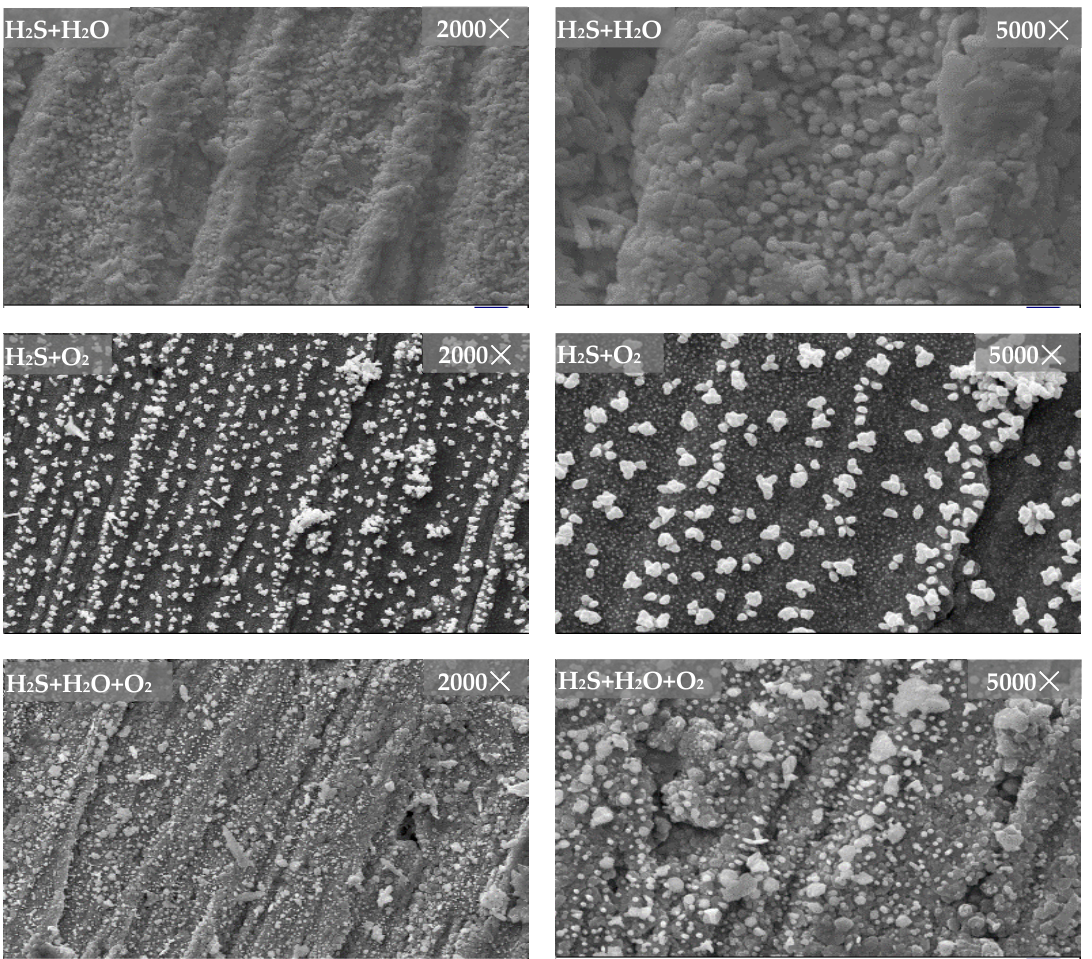
Figure 6. SEM images of corrosion products of copper sheets after corrosion tests in H 2 S, H 2 S + H 2 O, H 2 S + O 2 and H 2 S + O 2 + H 2 O.